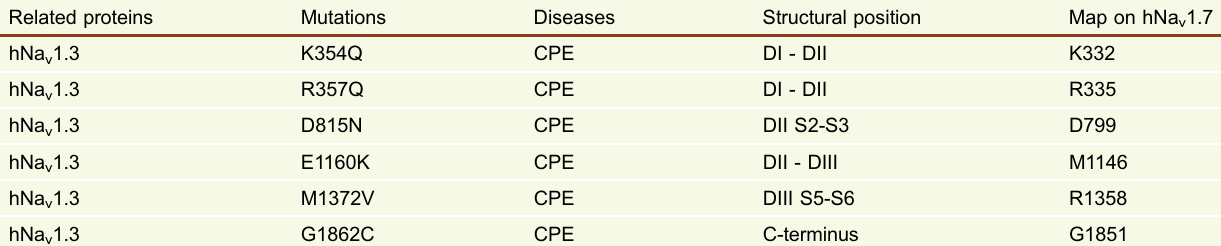
Table 4. Structural mapping of disease-related mutations identi fi ed in human Na v 1.3 Related